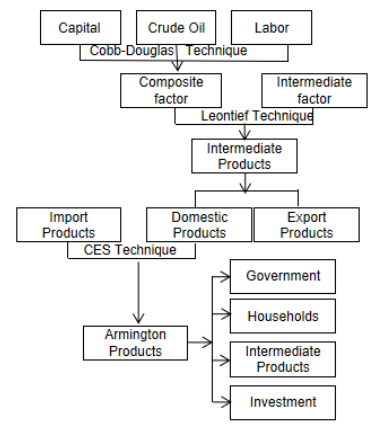
Figure 1. Diagram of OE-CGE